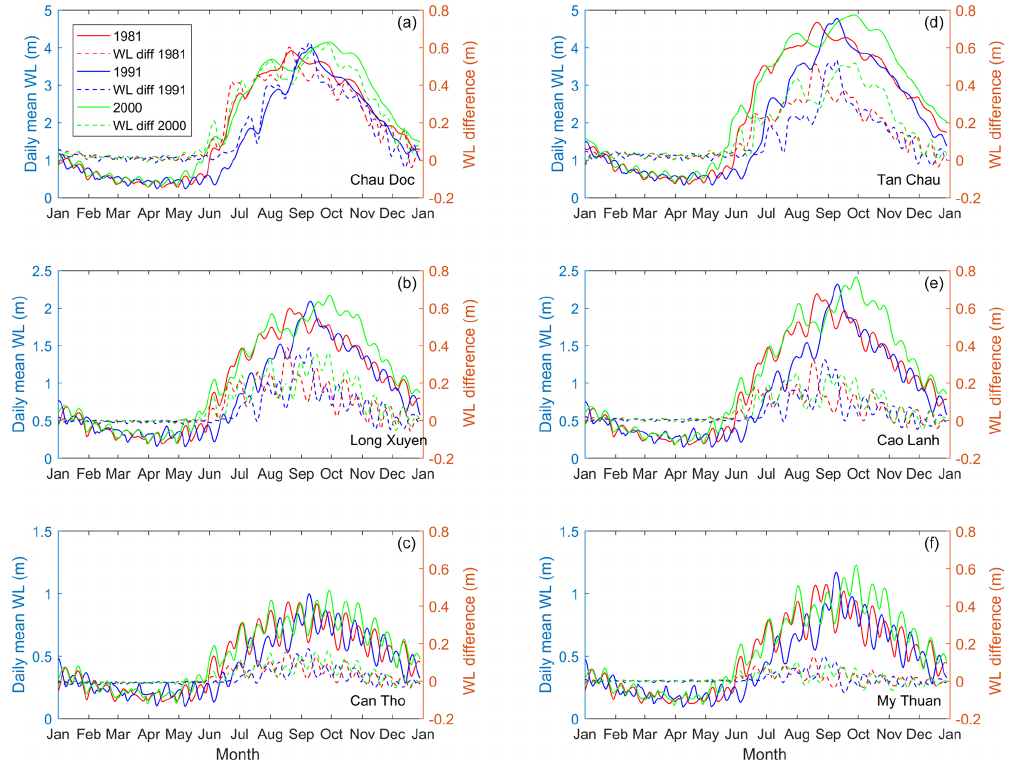
Figure 12. Simulated daily mean water levels in the high-flood years of 1981, 1991 and 2000 at selected stations on the Mekong River. The dashed lines indicate water level differences due to the impacts of high